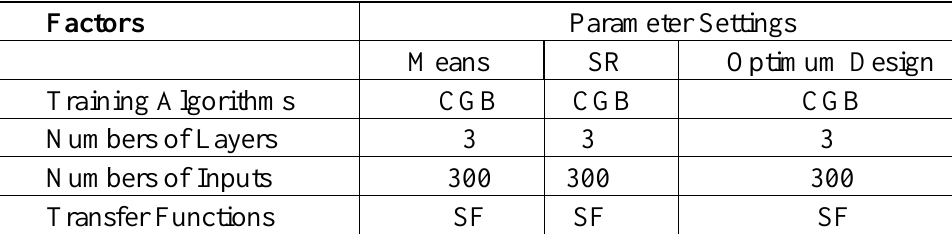
Table 5. Results for ANN Parameter